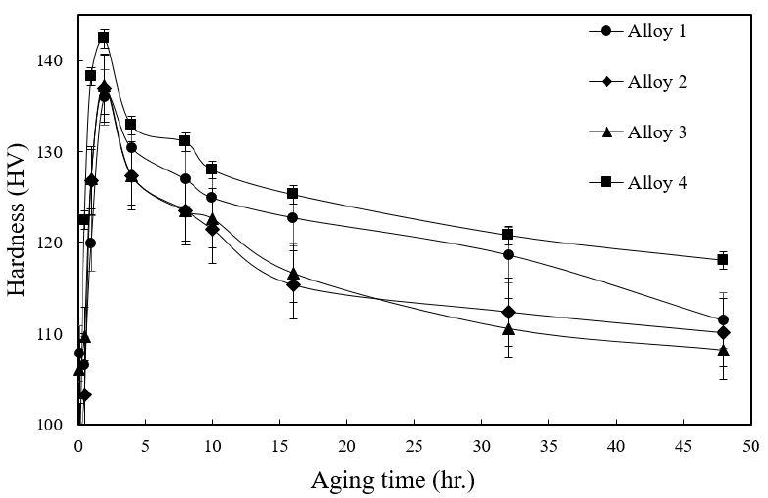
Figure 1. Evolution of microhardness of Alloy-1, Alloy-2, Alloy-3 and Alloy-4 specimens as a function of aging time.